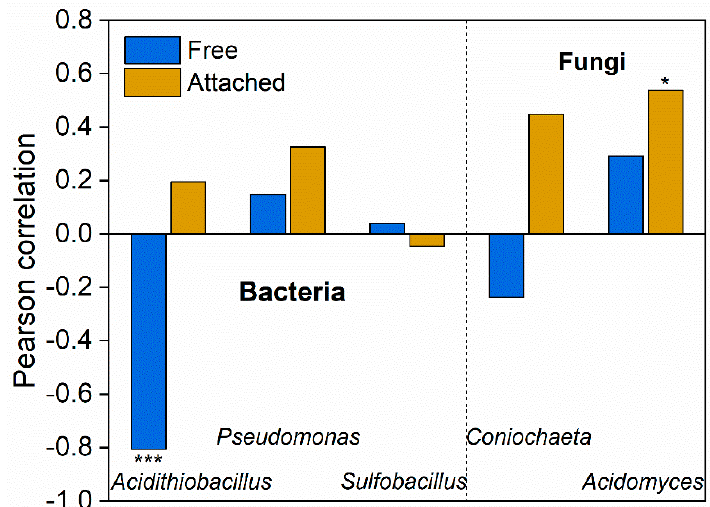
Figure 4. Pearson correlations between soil Cd removal and the dominant bacterial and fungal gen- era in the free and a tt ached microbial communities. Level of signi fi cance: * p < 0.05, *** p < 0.001. in the free and attached microbial communities. Level of significance: * p < 0.05, *** p < 0.001.